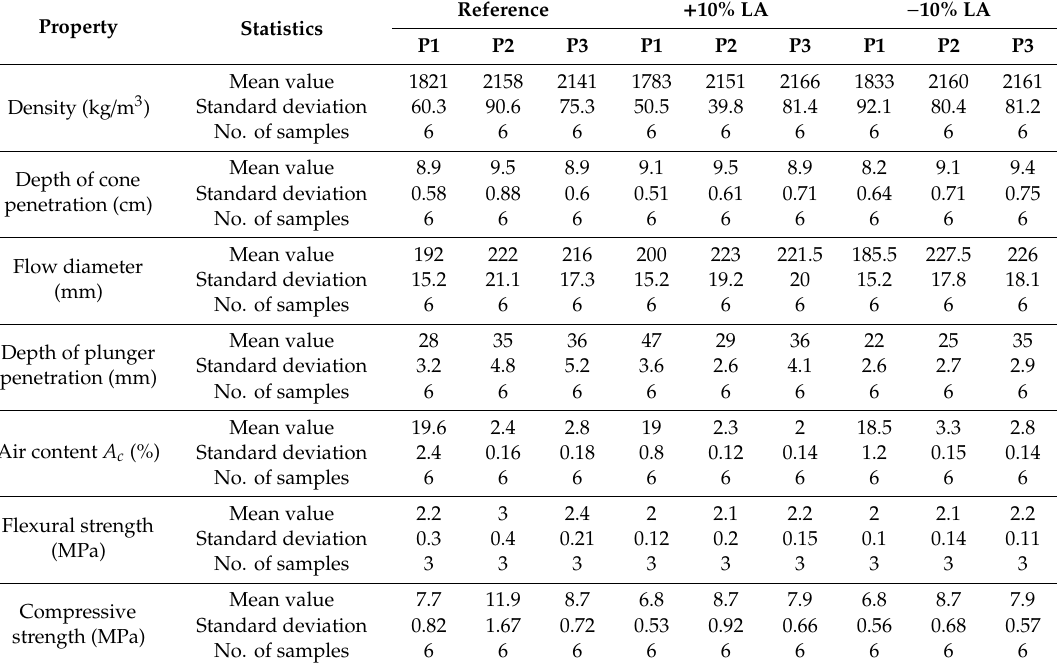
Table 9. Results of tests of the influence of mistakes in dosing of lime / APA on properties of plaster.